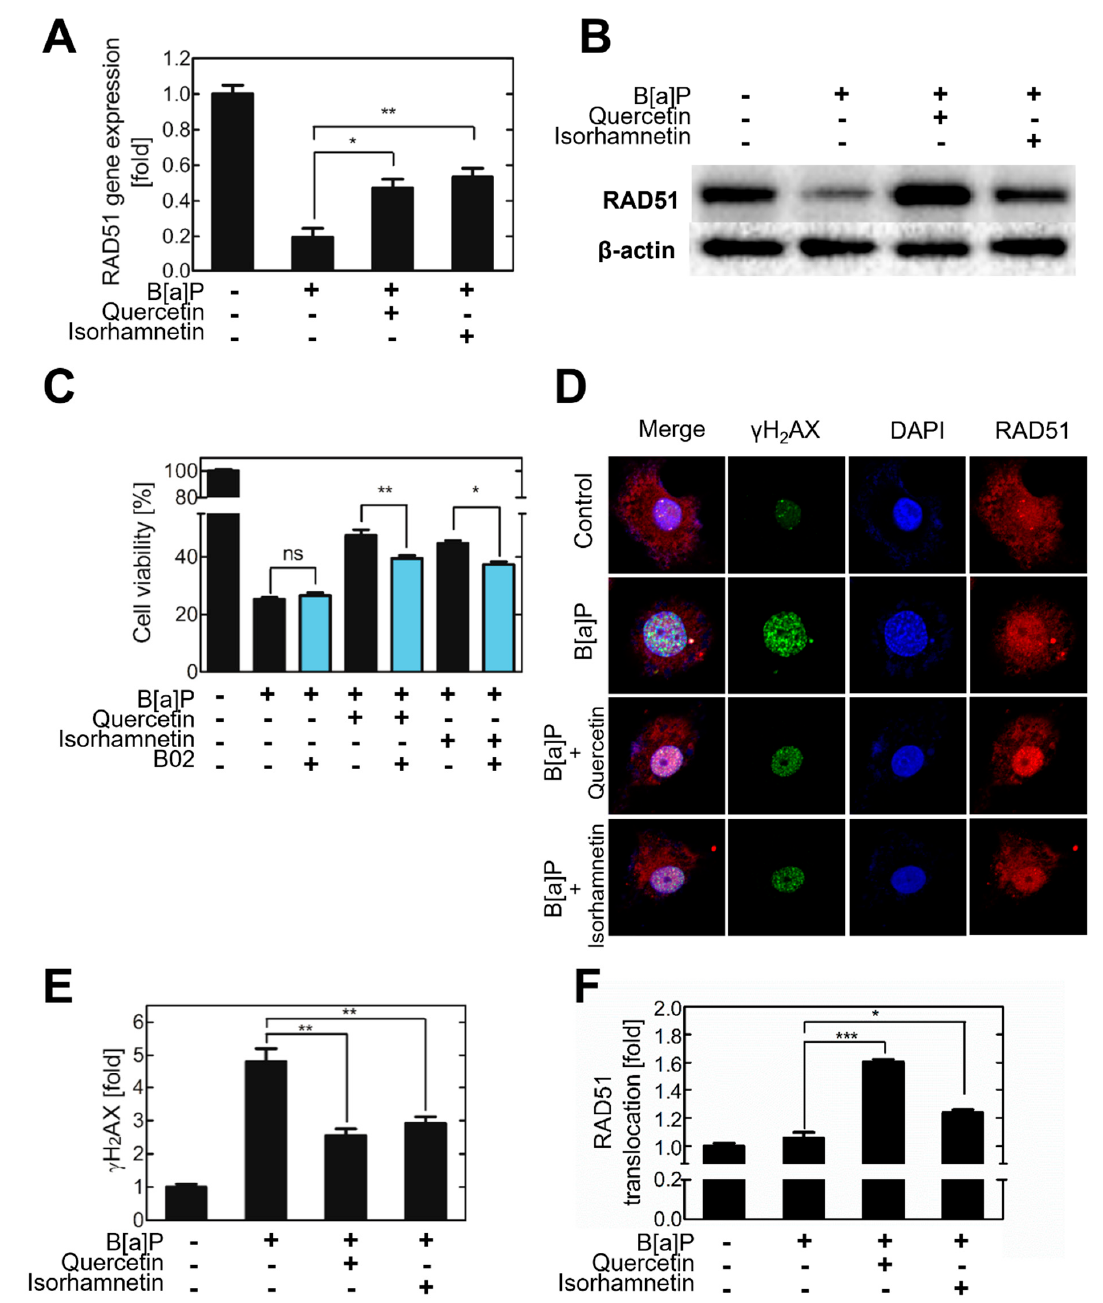
Figure 3. Quercetin or isorhamnetin upregulated RAD51 and thereby decreased the number of DSBs. ( A ) To validate the expression level of RAD51 from the microarray analysis results, cellular RAD51 mRNA was quantitated via reverse transcription − quantitative polymerase chain reaction. ( B ) The protein level of RAD51 was evaluated via Western blotting. ( C ) The viability of cells co − treated with quercetin or isorhamnetin and B[a]P after administration of a RAD51 inhibitor was evaluated. ( D ) γ H 2 AX and RAD51 expression patterns were evaluated via fluorescence microscopy by using Alexa 488 and 555, respectively. The fluorescence intensity from ( E ) γ H 2 AX is expressed as a bar graph. ( F ) The translocation of RAD51 to the nucleus was quantified and expressed as a bar graph. ns; not significant, * p < 0.05, ** p < 0.01, *** p < 0.001, C; control, Q; quercetin, I; isorhamnetin, B; B[a]P, B02; inhibitor of